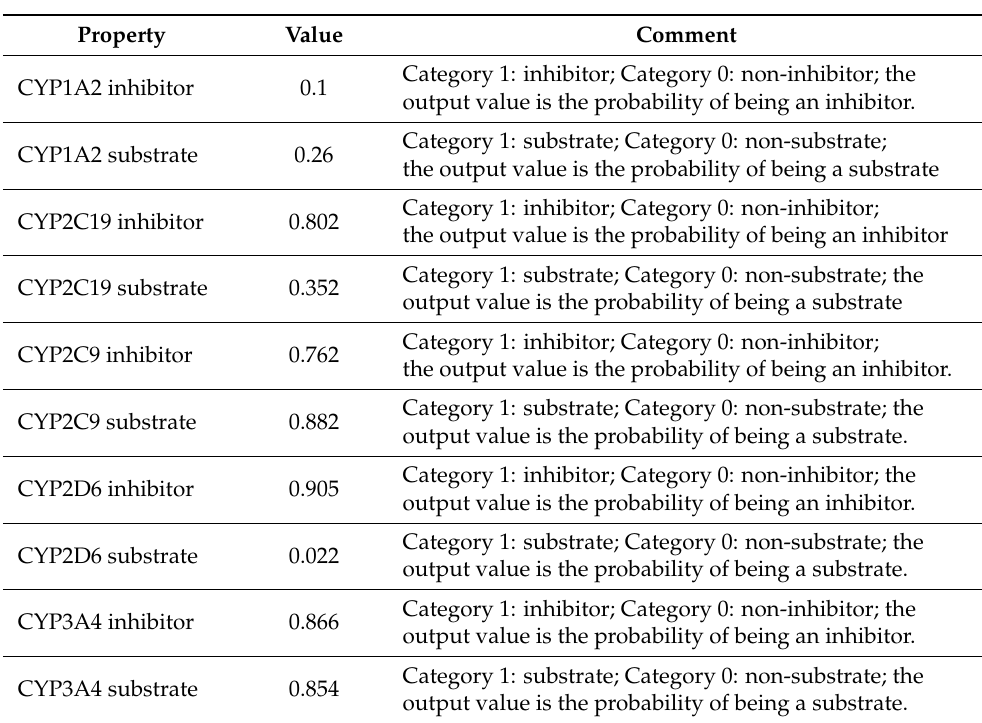
Table 10. The properties of the drug metabolism of compound 1 .